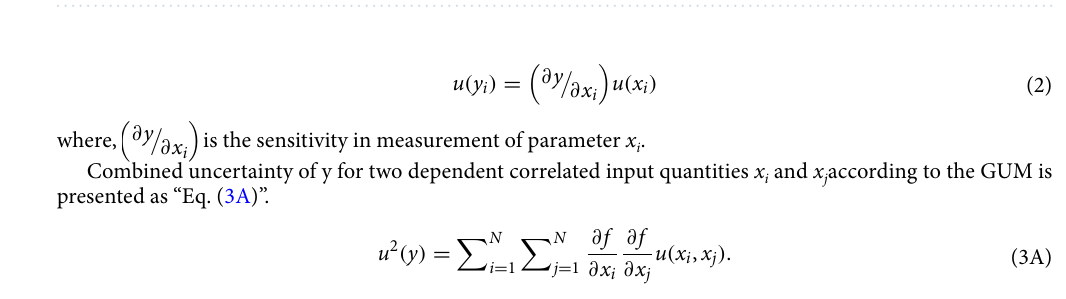
Table 3. Standard uncertainty, u A ( x i ) temperature